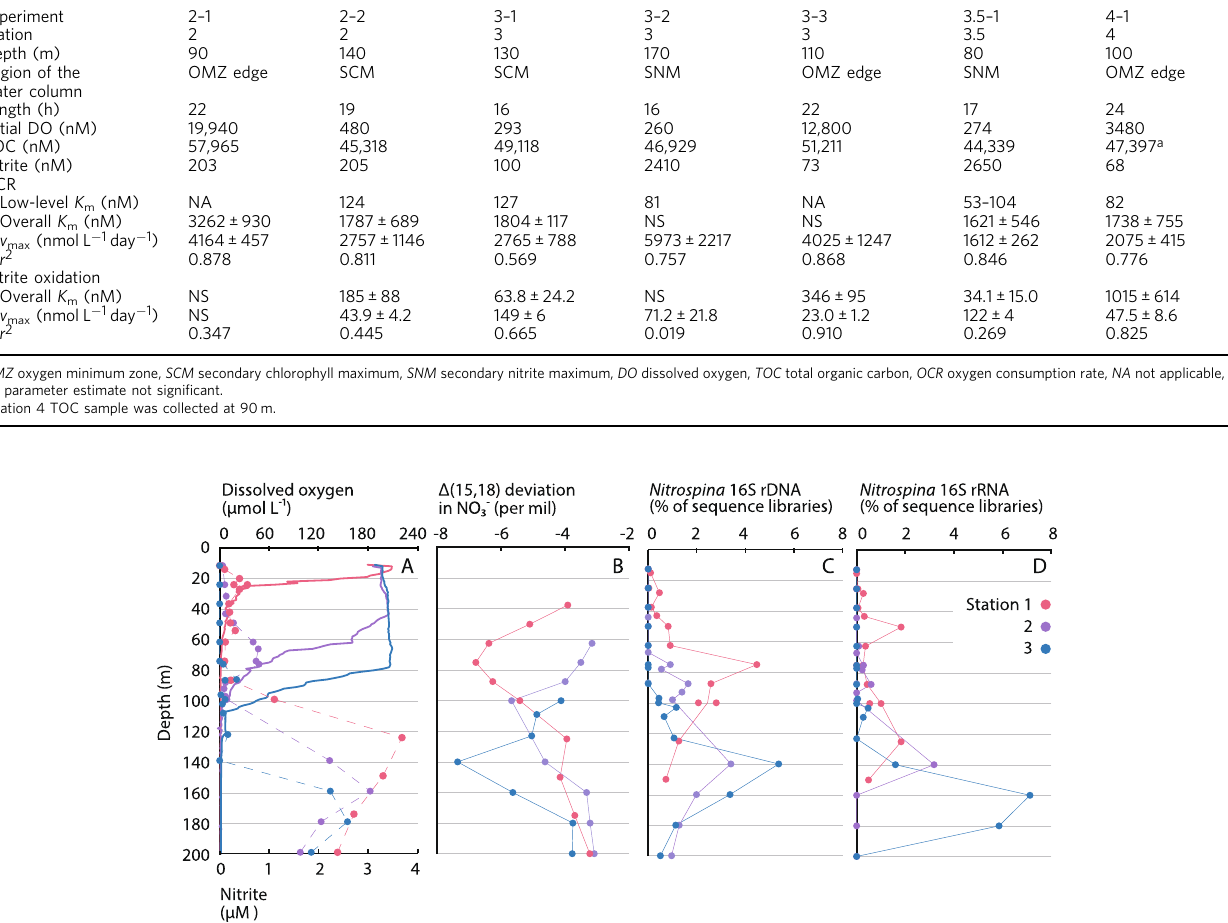
Fig. 5 Nitrate isotopic composition and Nitrospina bacteria. Depth pro fi les of A dissolved oxygen (solid lines) and nitrite (data points connected by dashed lines), B Δ (15,18) dual-isotope deviations in nitrate, and Nitrospina amplicon sequence variants (ASVs) as a percentage of C 16S rDNA sequence libraries and D 16S rRNA sequence libraries. Colors denote different sampling